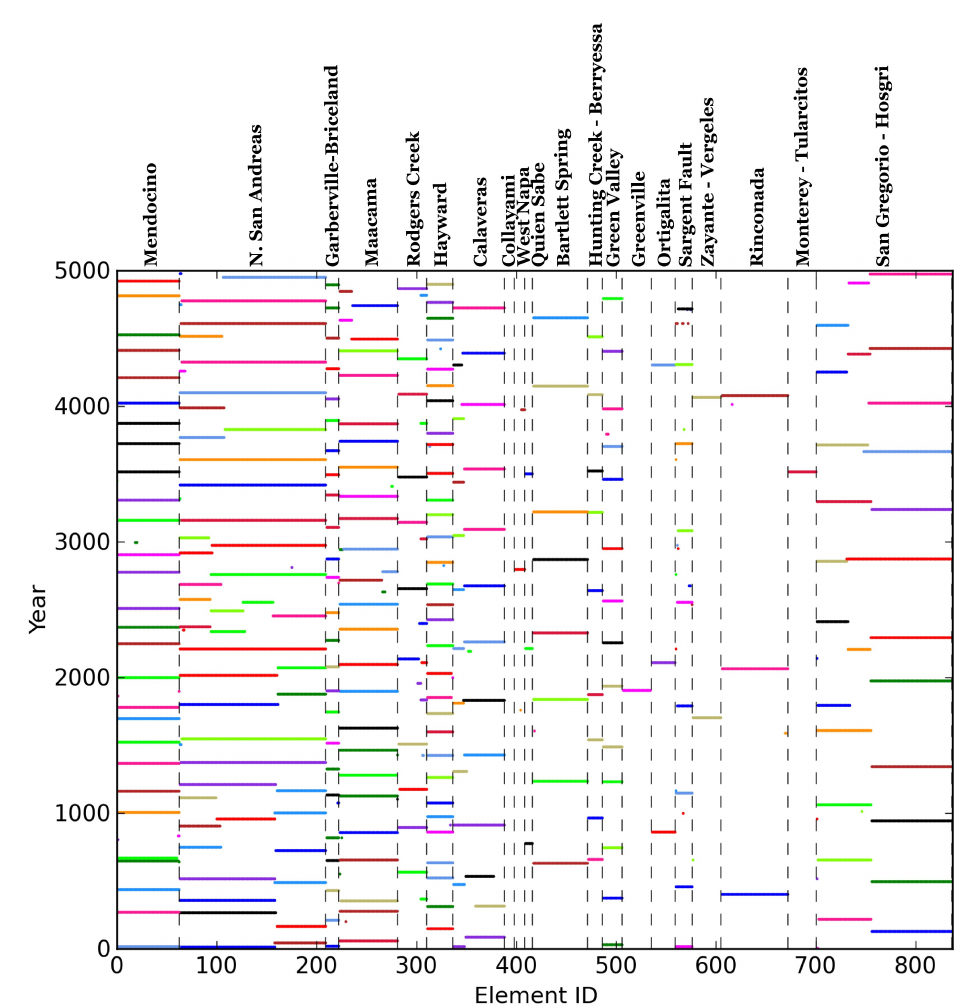
Fig. 2. A catalog of earthquakes that occurred during 5000yr of our VC simulation of northern California seismicity. Elements on a fault are numbered from north to south and have a length of 3km. Surface ruptures are shown as colored